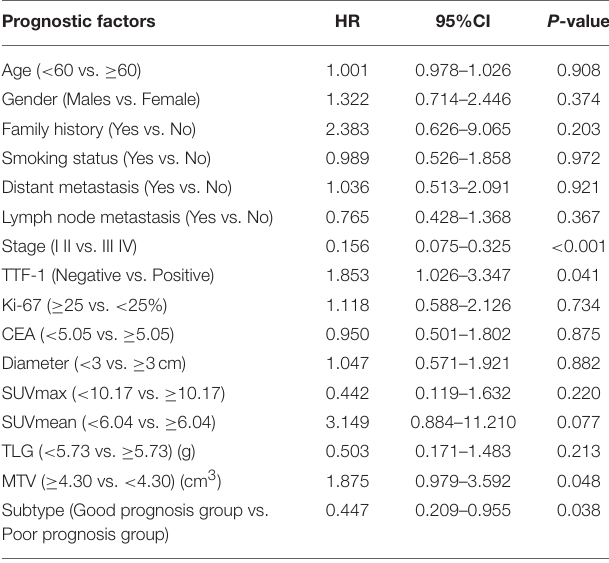
FIGURE 2 | Receiver operating characteristic (ROC) curves of maximal standard uptake value (SUVmax) and combination of three factors (Distant metastasis, Ki-67, and SUVmax) for predicting pathological subtype in good prognosis group and poor prognosis group.